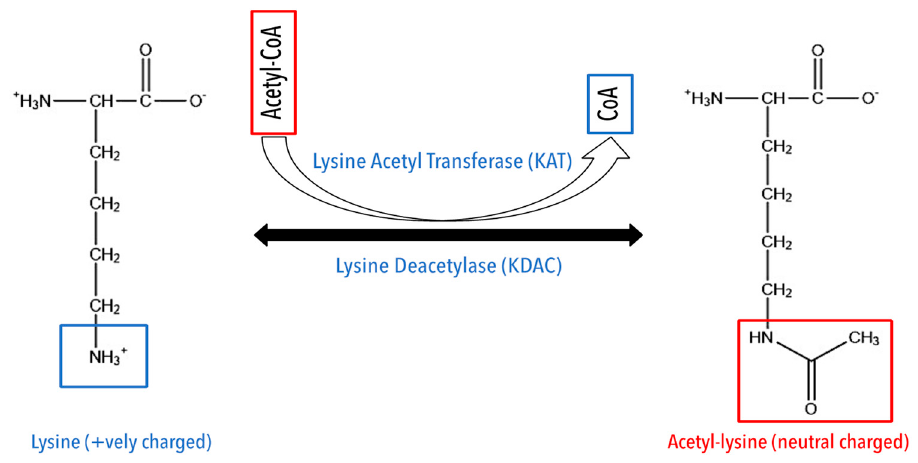
Figure 1. Schematic representation of the acetylation process.